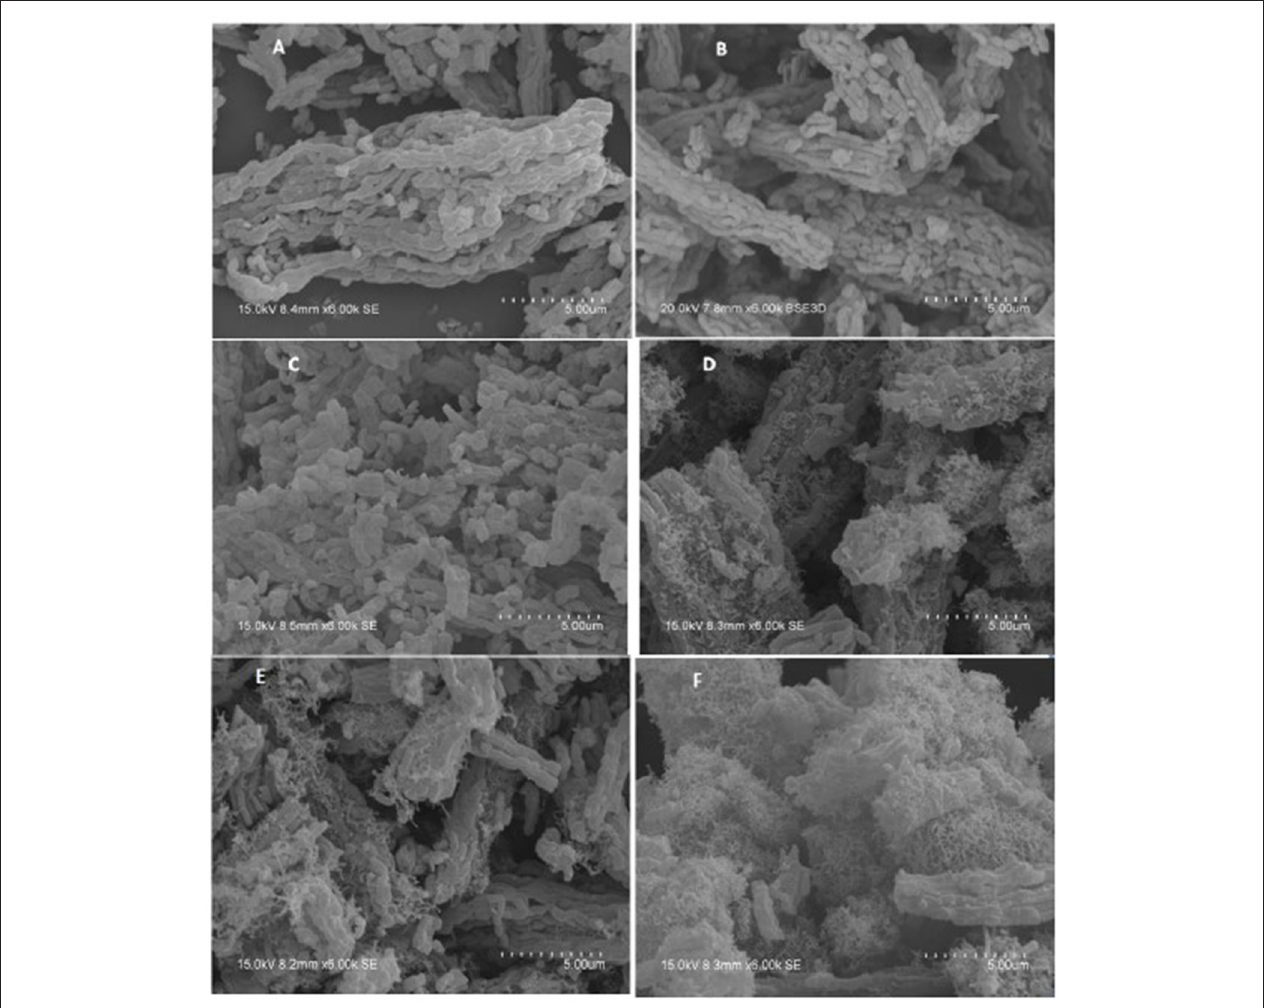
FIGURE 5 | SEM images of (A) 9IMPNi2CoA-A, (B) 15IMPNi4CoA-B, (C) 16IMPNi8CoA-C, (D) 10IMPNi6LaN-A, (E) 13IMPNi18LaN-B, and (F) 16IMPNi11LaN-C spent samples at 550 ◦ C.